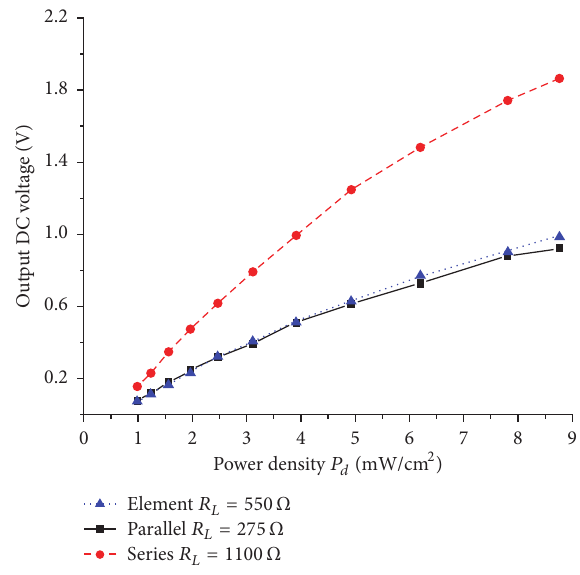
Figure 14: Measured output DC voltage.